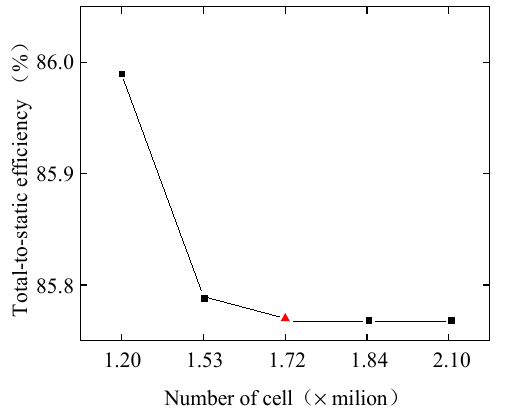
Figure 4. Mesh independence study. Table 5. Table resolution test of the thermal-physical